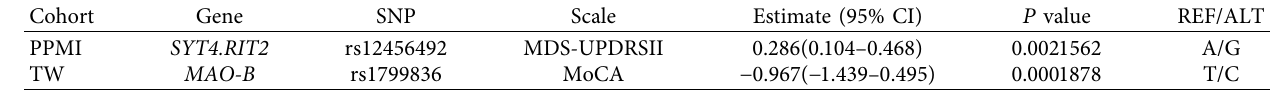
Table 2: Association between SNPs and progression of the separate scale in the TW and PPMI cohorts.